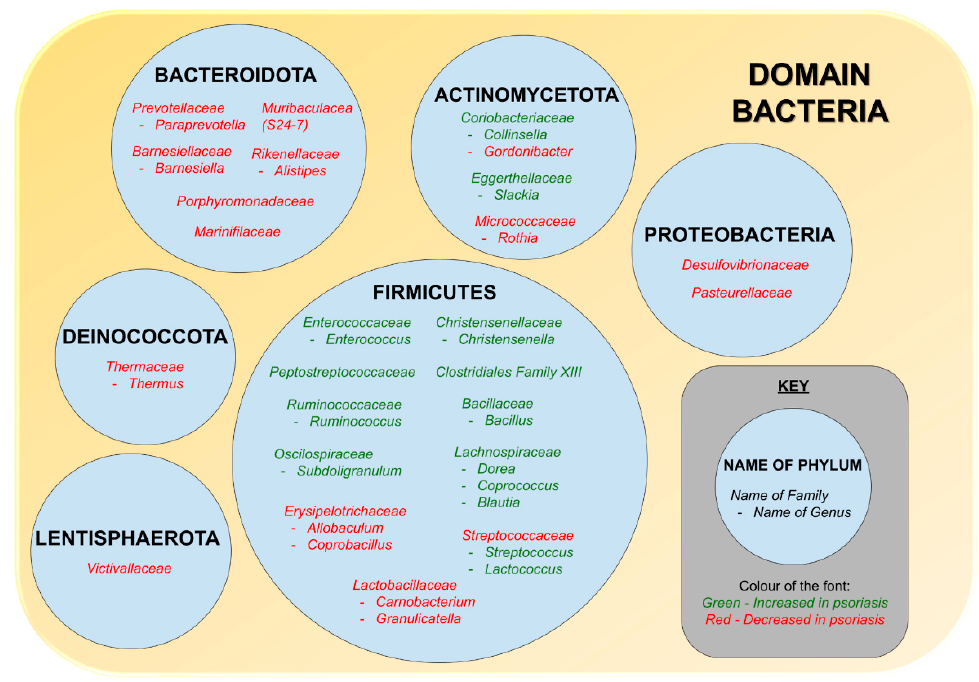
Figure 1. The association between gut microbiota and psoriasis. Data extracted from Scepanovic et al. [110] , Calcinaro et al. [119] , Lavasani et al. [120] , Kostic et al. [122] , Scher et al. [123] , and Eppinga et al. [124].